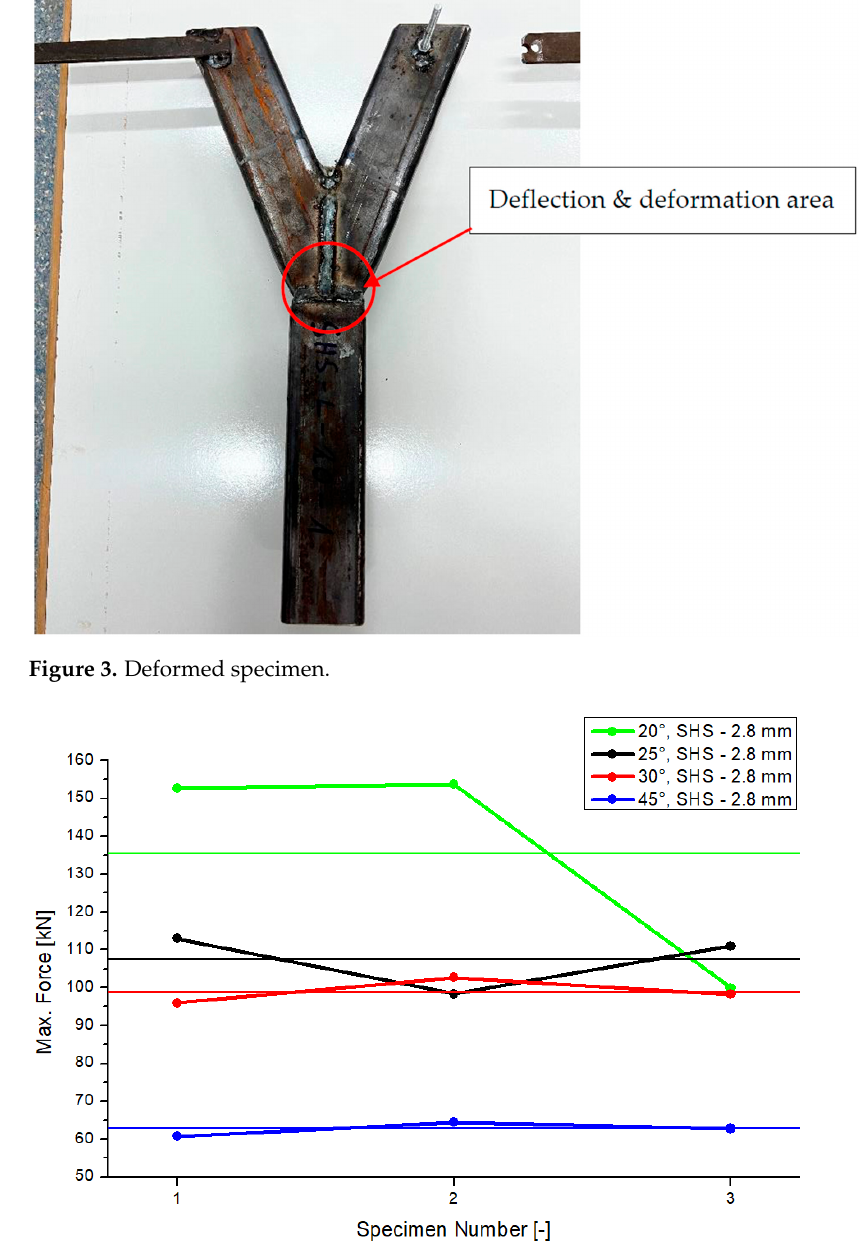
Figure 3. Deformed specimen.